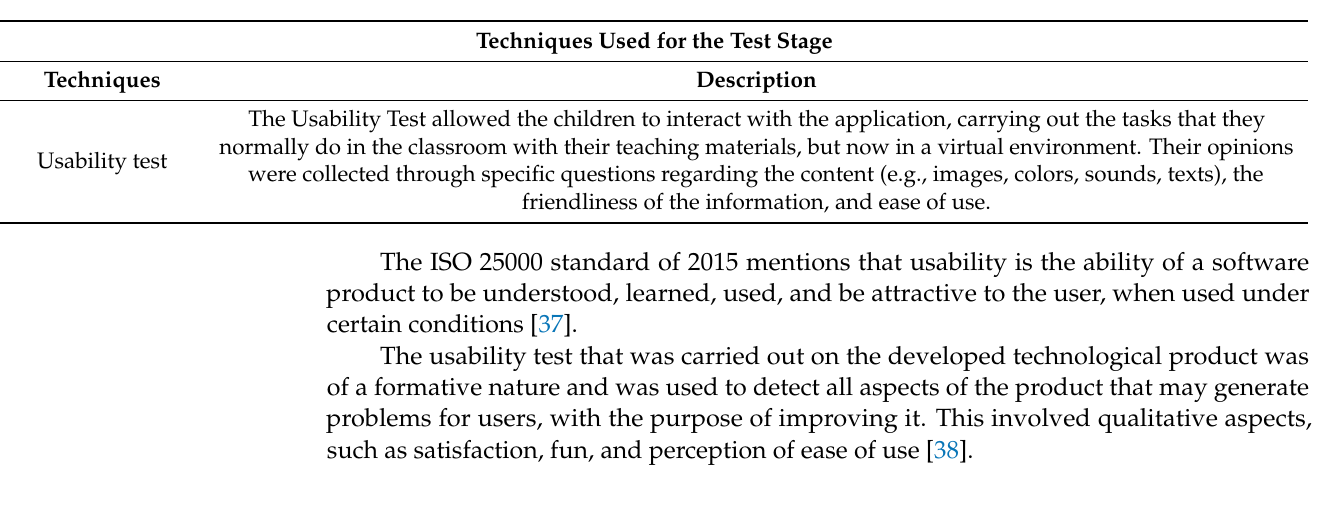
Table 7. Description of techniques used in the Test or Evaluate stage.